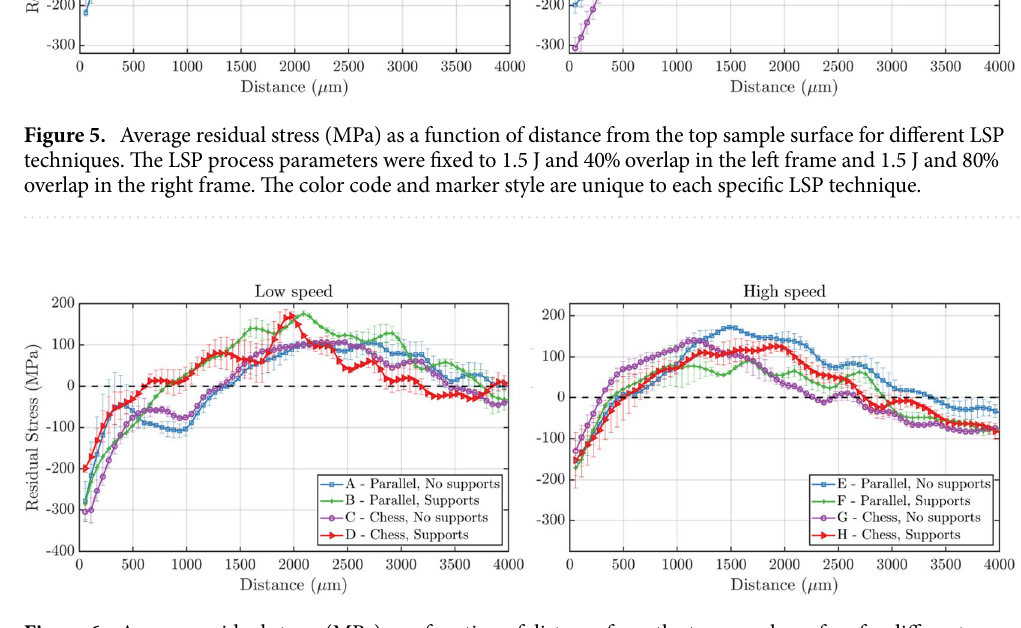
Figure 6. Average residual stress (MPa) as a function of distance from the top sample surface for different LPBF processing parameters. The plots are grouped by LPBF scanning speed set to 300mm/s (left) and 500mm/s (right). For both graphs, the LSP technique was 3D-LSP with 1.5 J laser energy and 80 % spot overlap. The color code and marker style are unique to each specific LPBF processing